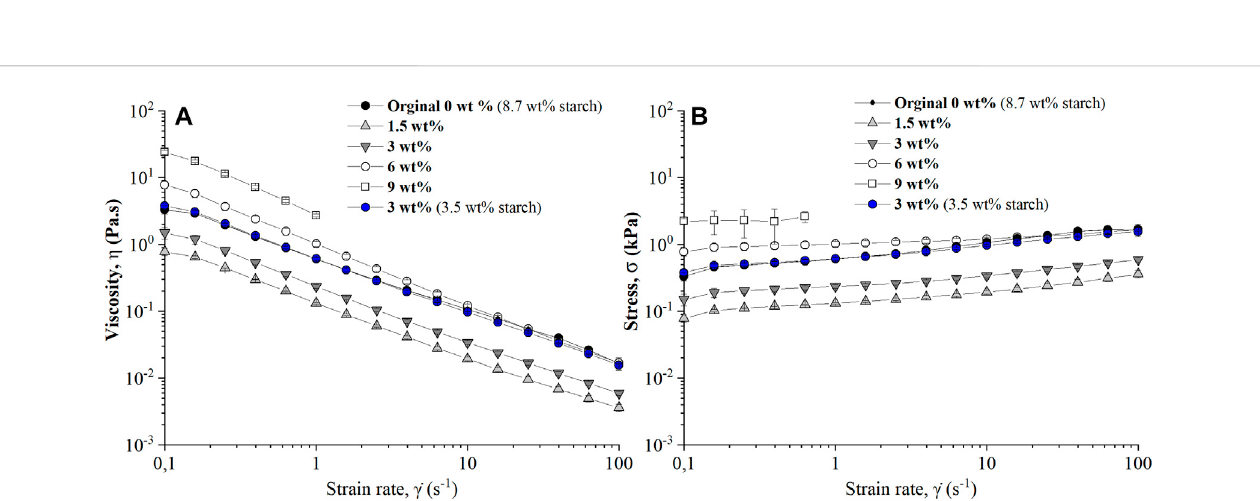
Frontiers in Food Science and